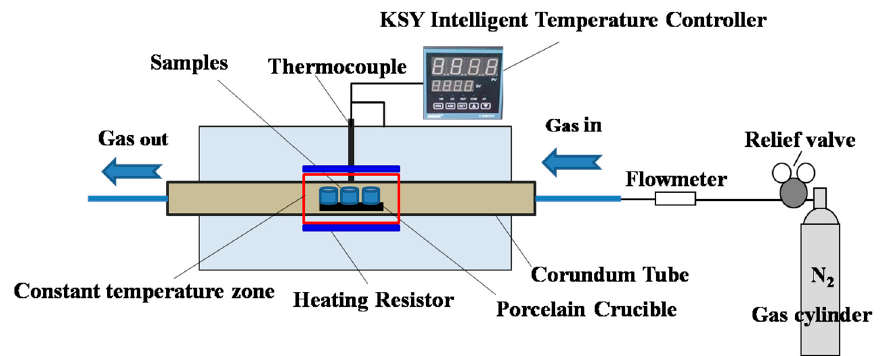
Figure 3. Schematic diagram of the equipment for soda ‐ ash roasting.